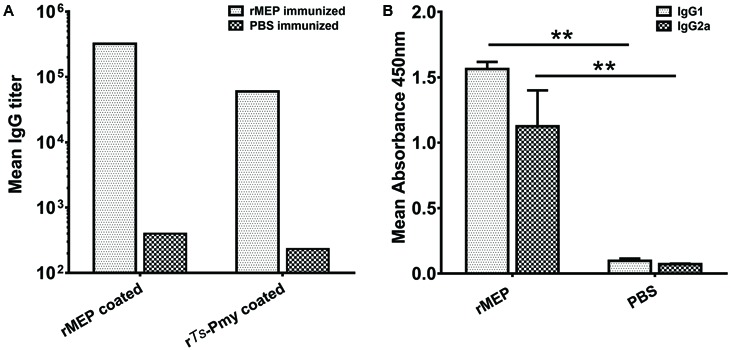
Serological antibody responses to immunization of rMEP measured by ELISA. (A) Specific IgG titers against rMEP or rTs-Pmy in the sera of rMEP or PBS immunized mice were detected. The total IgG is shown as the geometric mean titer of six mice within the group (one representative experiment out of three). (B) The subtype IgG1 and IgG2a responses (OD at 1:200 dilutions) in the sera of rMEP or PBS immunized mice were detected. The values are shown as the mean absorbance of six mice ± SD (one representative experiment out of three). ∗∗p < 0.01.